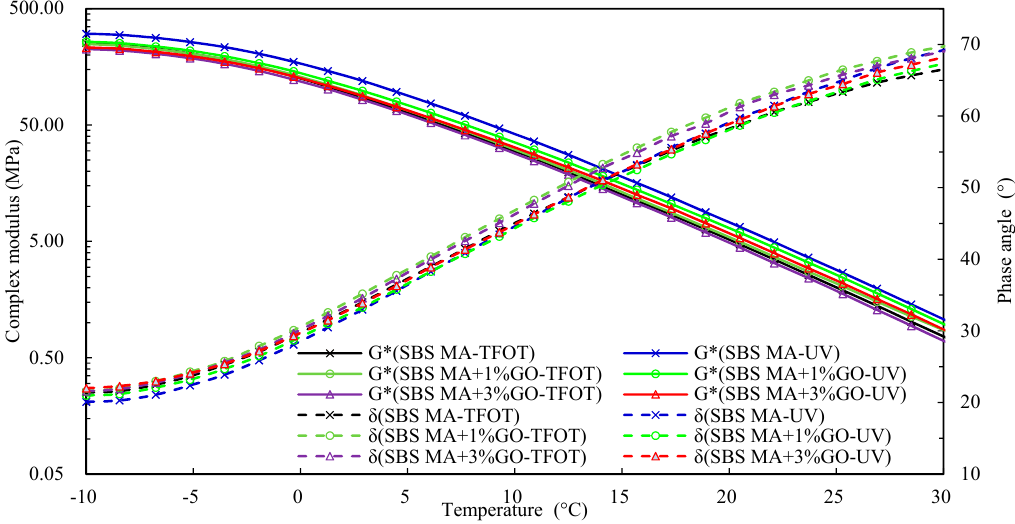
Figure 13. Complex modulus of SBS MA and GO-modified SBS MA after TFOT and nine days UV aging.